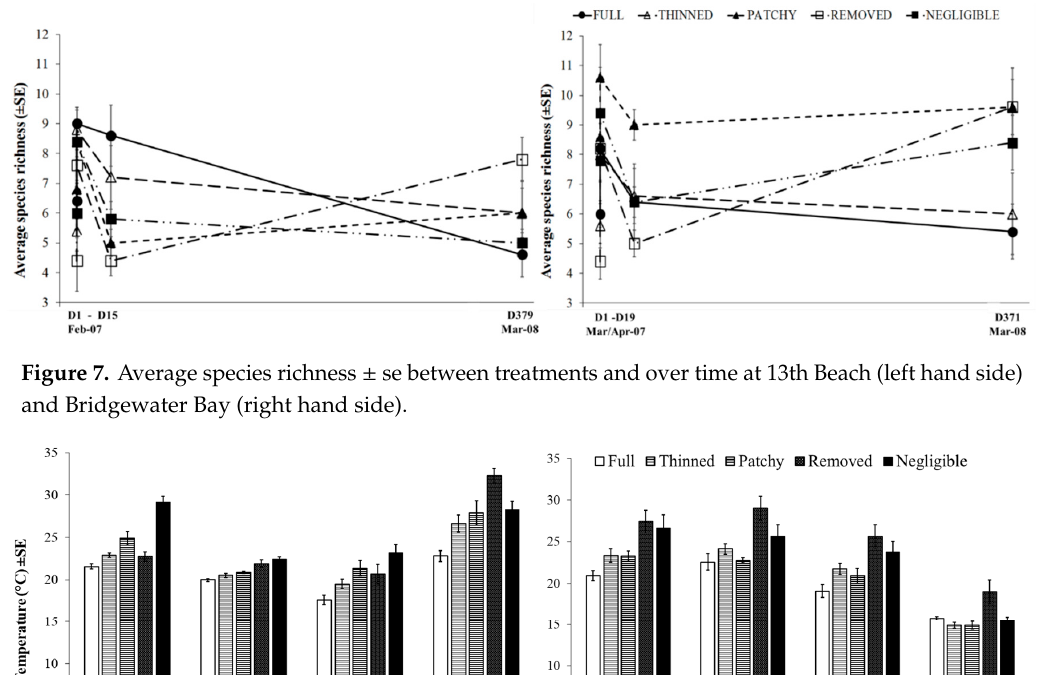
Figure 9. Average light intensity ± se as relative units between treatments and over time at 13th Beach (left hand side) and Bridgewater Bay (right hand side). 4. Discussion 4.1. Hormosira banksii as An Ecosystem Engineer The results of this study support the suggestion of Keough and Quinn [5] that ‘established’ H. banksii canopies function as ecosystem engineers on Victorian rocky shores by providing environmentally buffered refuges (cool and shaded) for particular species (see also References [2,9,12,21,27]). We found differences in assemblages associated with different natural states of the canopy (full, patchy, negligible cover) across four sites; and like other studies [2,5,9,12,21] a loss of